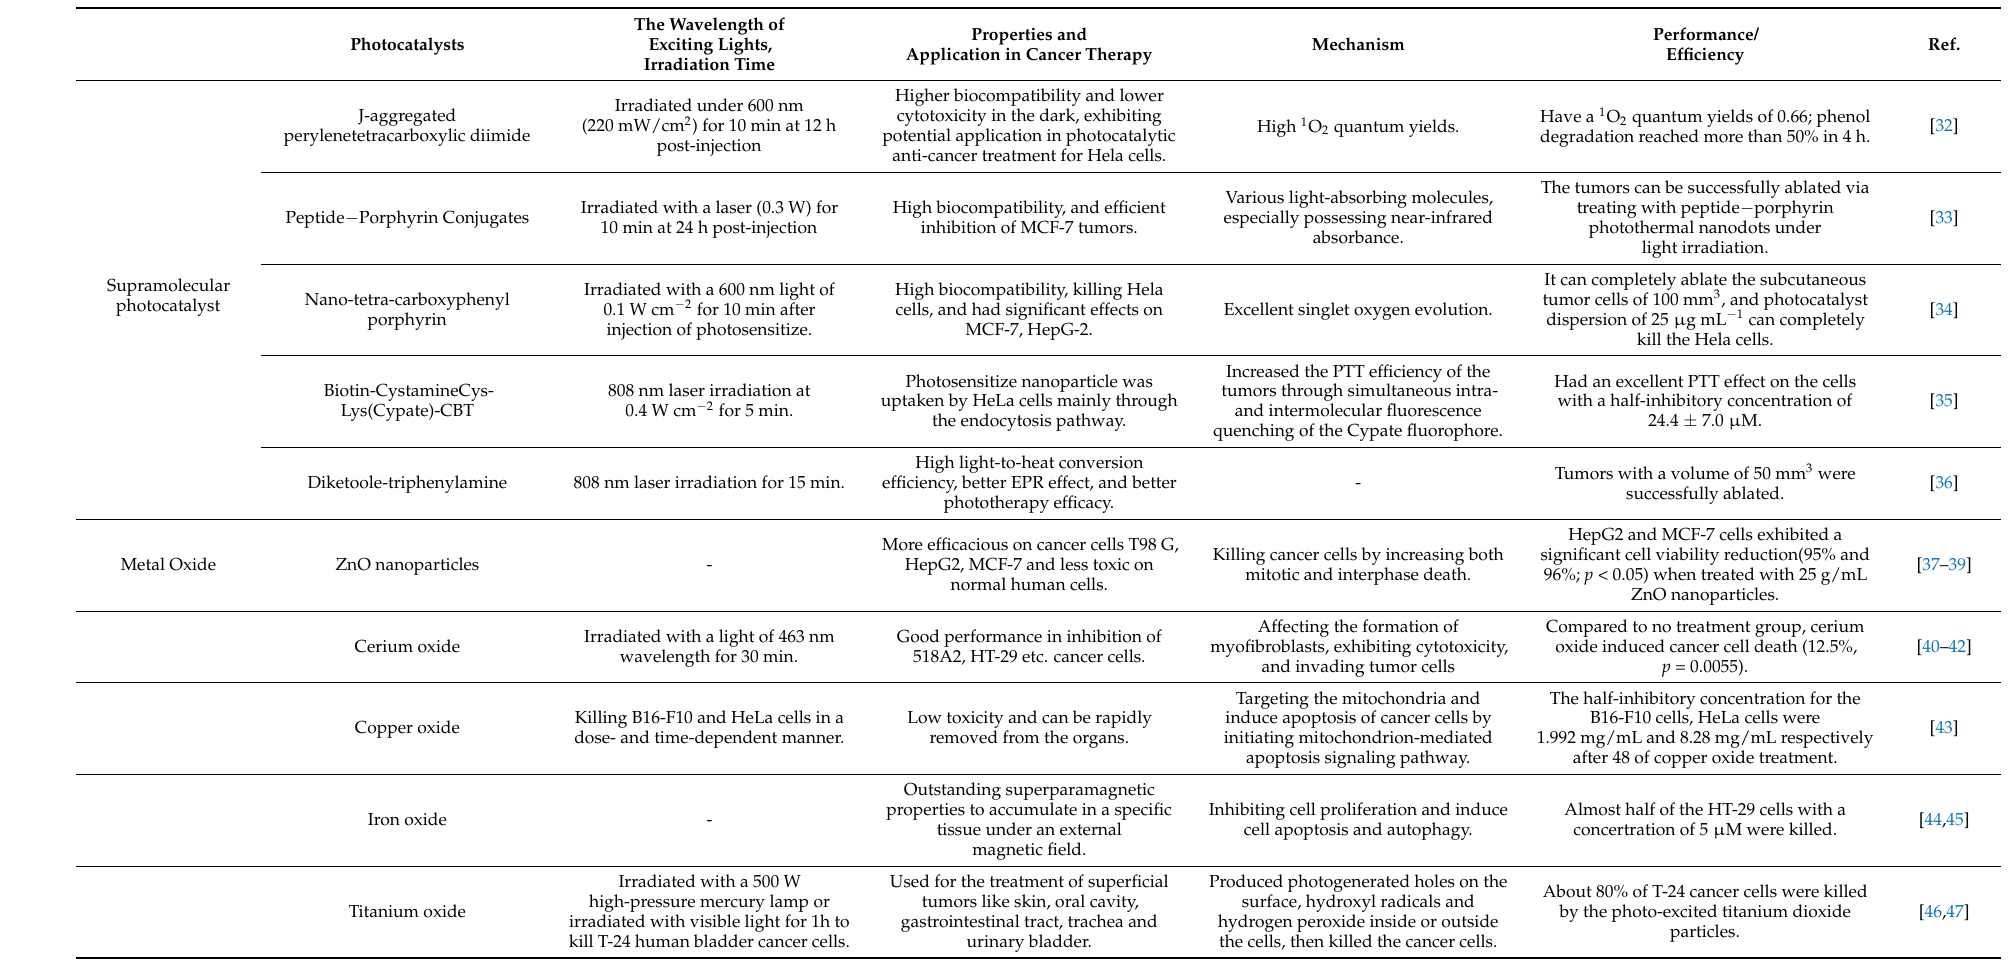
Table 1. Common photocatalysts for cancer